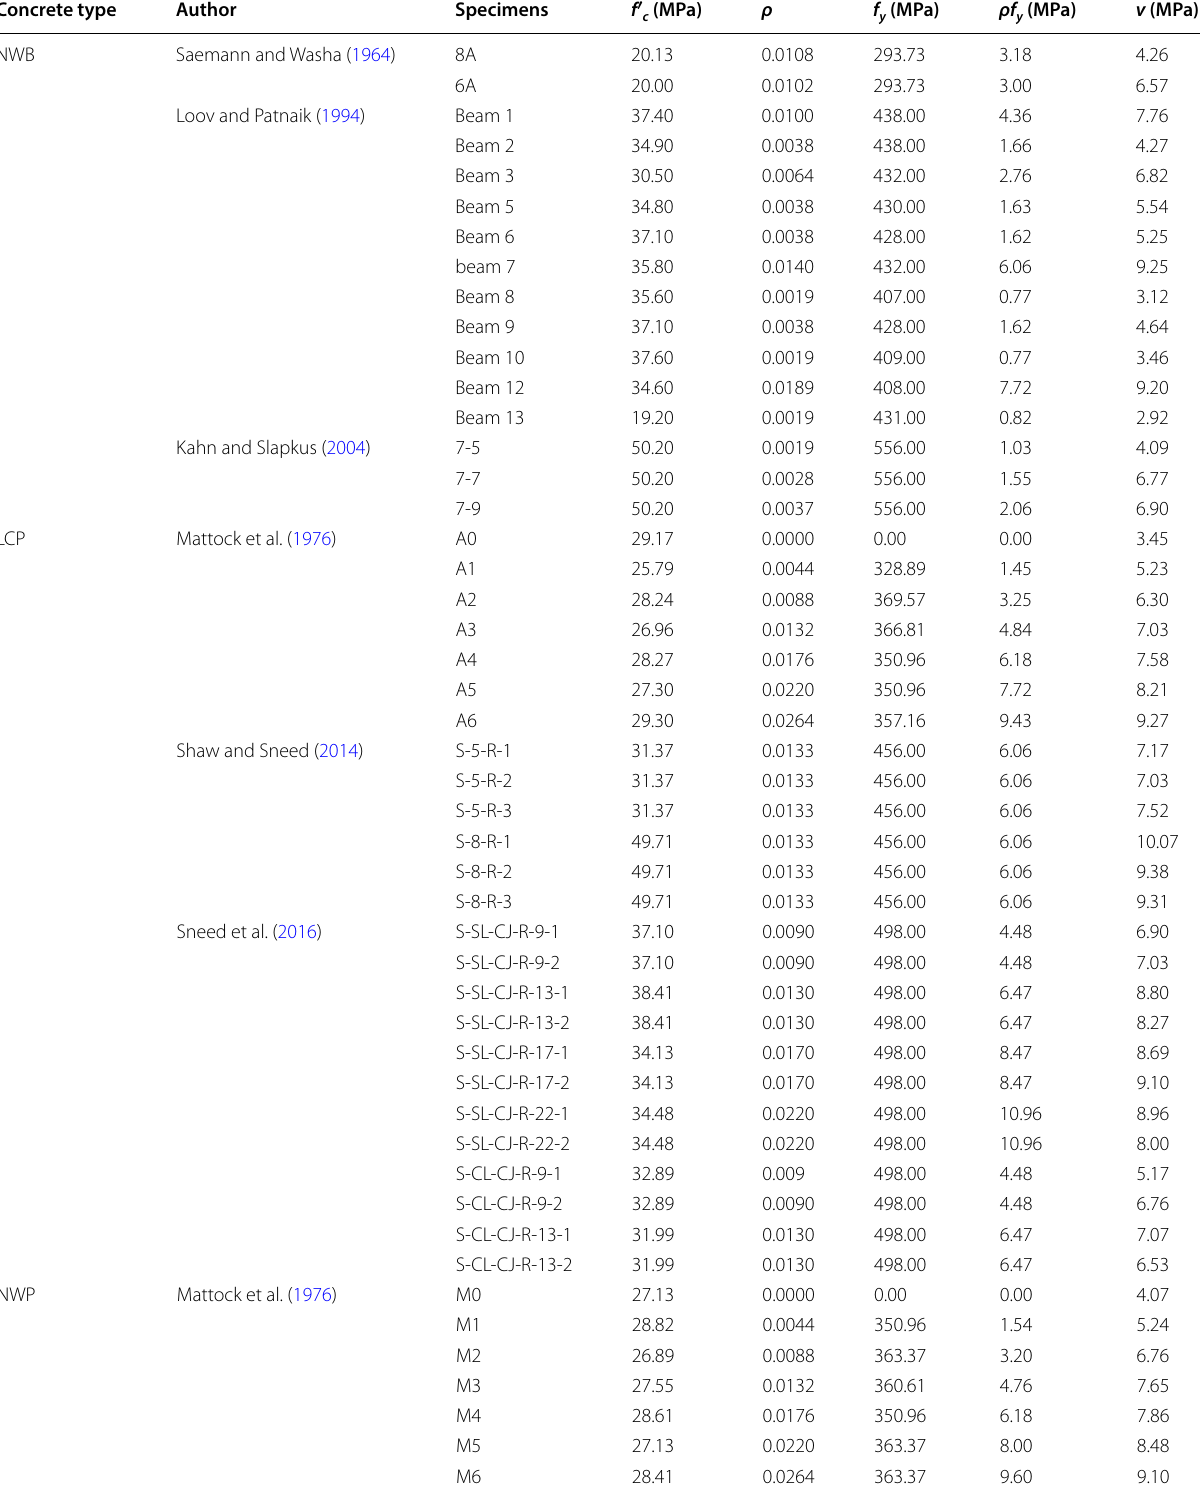
Table 8 Experimental results of other researchers’ with rough interface